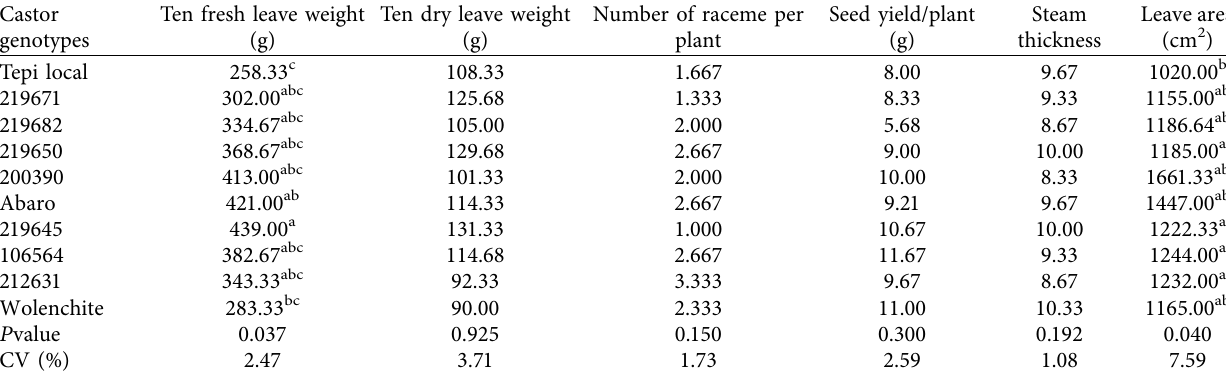
Table 2: Agronomic performance of castor genotypes under Tepi conditions.